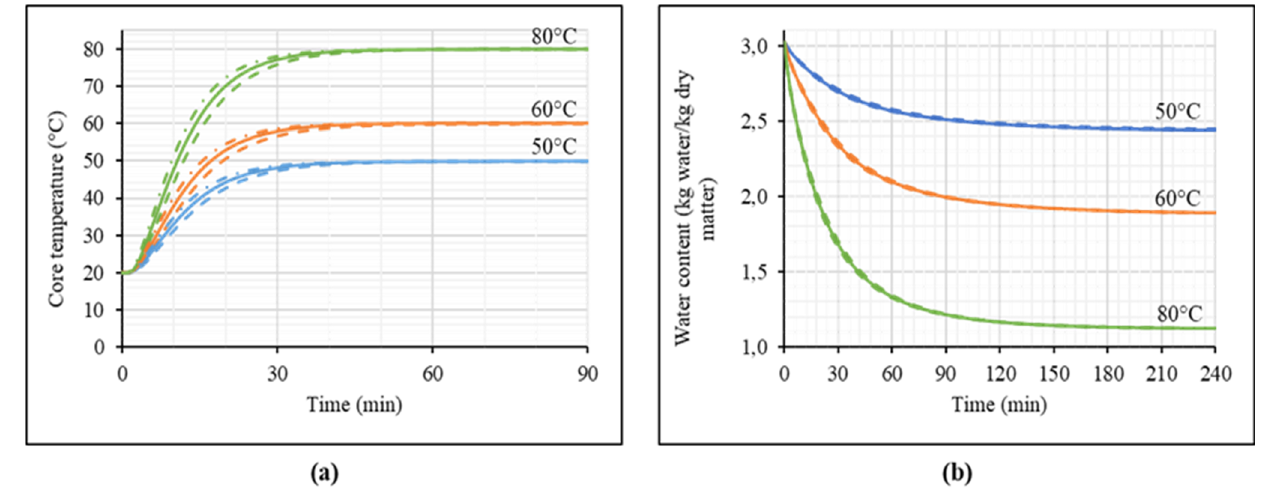
Figure 2. Simulation of ( a ) core temperature kinetics with heat conduction using Fourier’s law, the material properties reported in [28], and piecewise linear interpolation to our temperatures of ‘non- stirred water bath’ heat transfer coefficients taken from Kondjoyan et al. [48], and ( b ) time-course of average water content based on the mass transfer relation and its parameters taken from Kondjoyan et al. [48] for a sous-vide-packed, 3 cm thick, 6.5 cm diameter slice of meat immersed in a water bath at temperatures of 50 °C (blue), 60 °C (orange) and 80 °C (green). Dashed lines are the upper and lower bounds of the estimation based on the propagation of uncertainties from the material prop- erties and the boundary heat transfer coefficient.